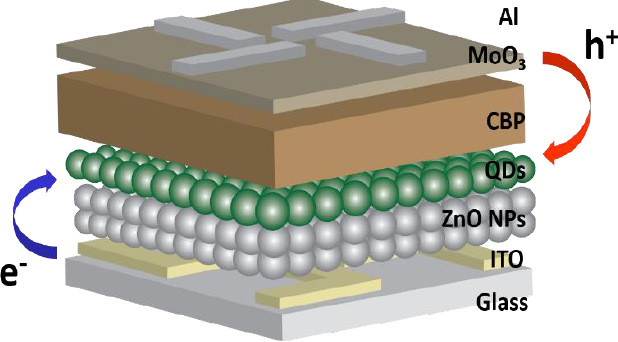
Figure 4. Device structure of the inverted quantum dots light-emitting diodes (QLEDs).